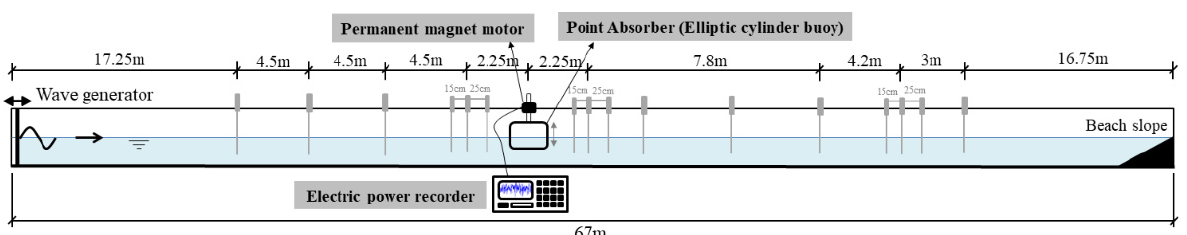
Figure 8. Experimental devices layout diagram for travelling wave cases.